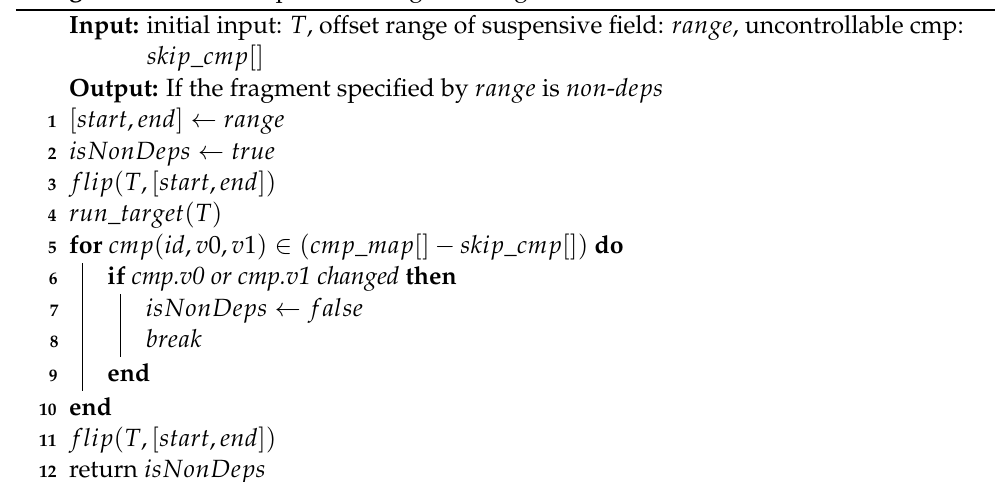
Algorithm 2: Non-deps field recognition algorithm.